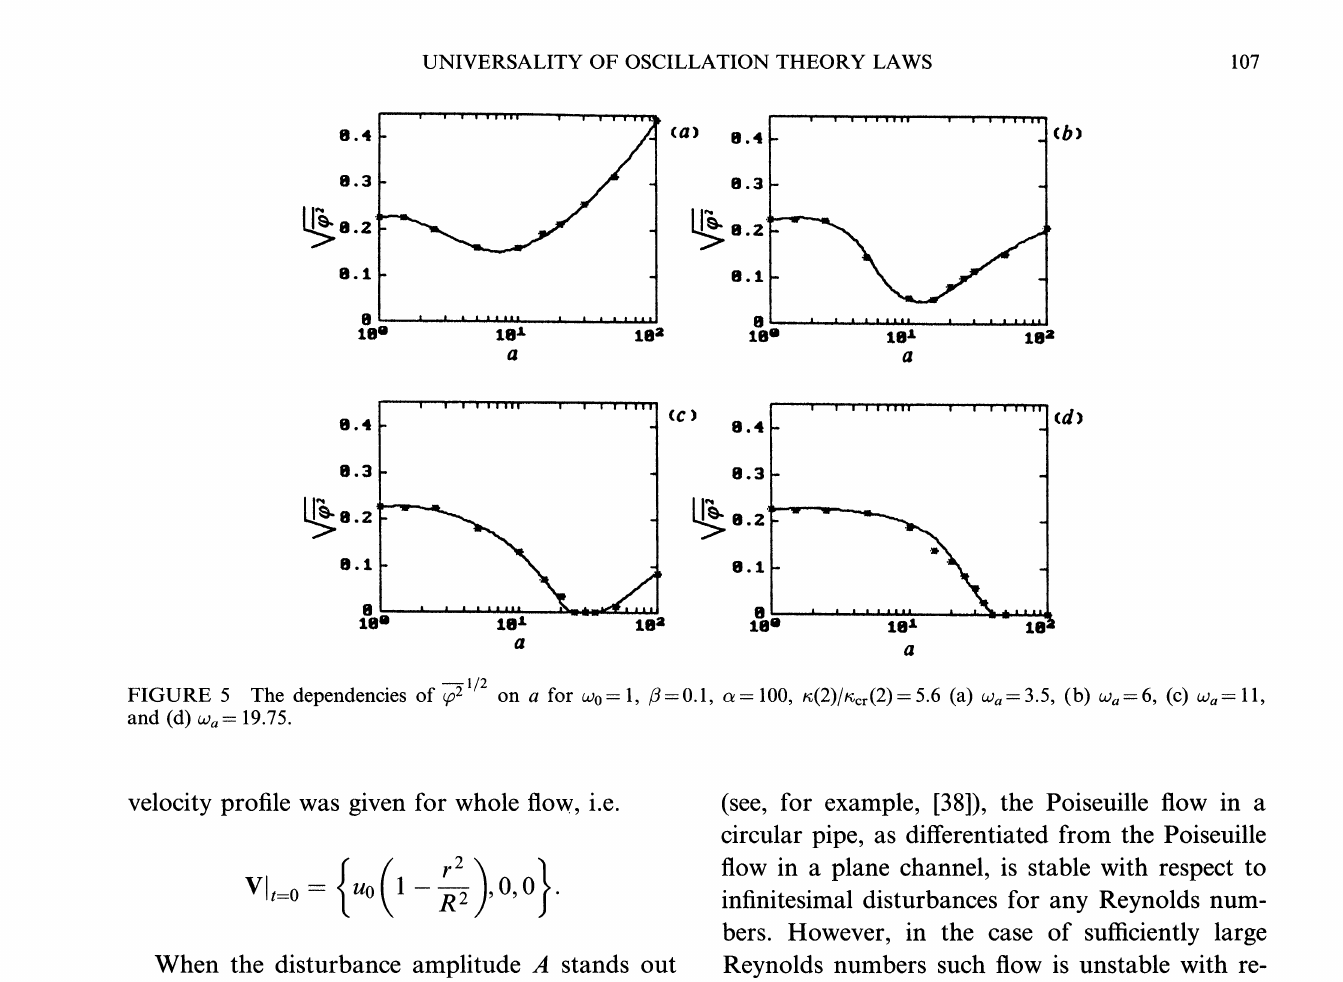
FIGURE 5 The dependencies of on a for w0=l, /3=0.1, c= 100, (2)/cr(2)=5.6 (a) a=3.5, (b) wa=6, (c) o= 11, and (d) Oa= 19.75.